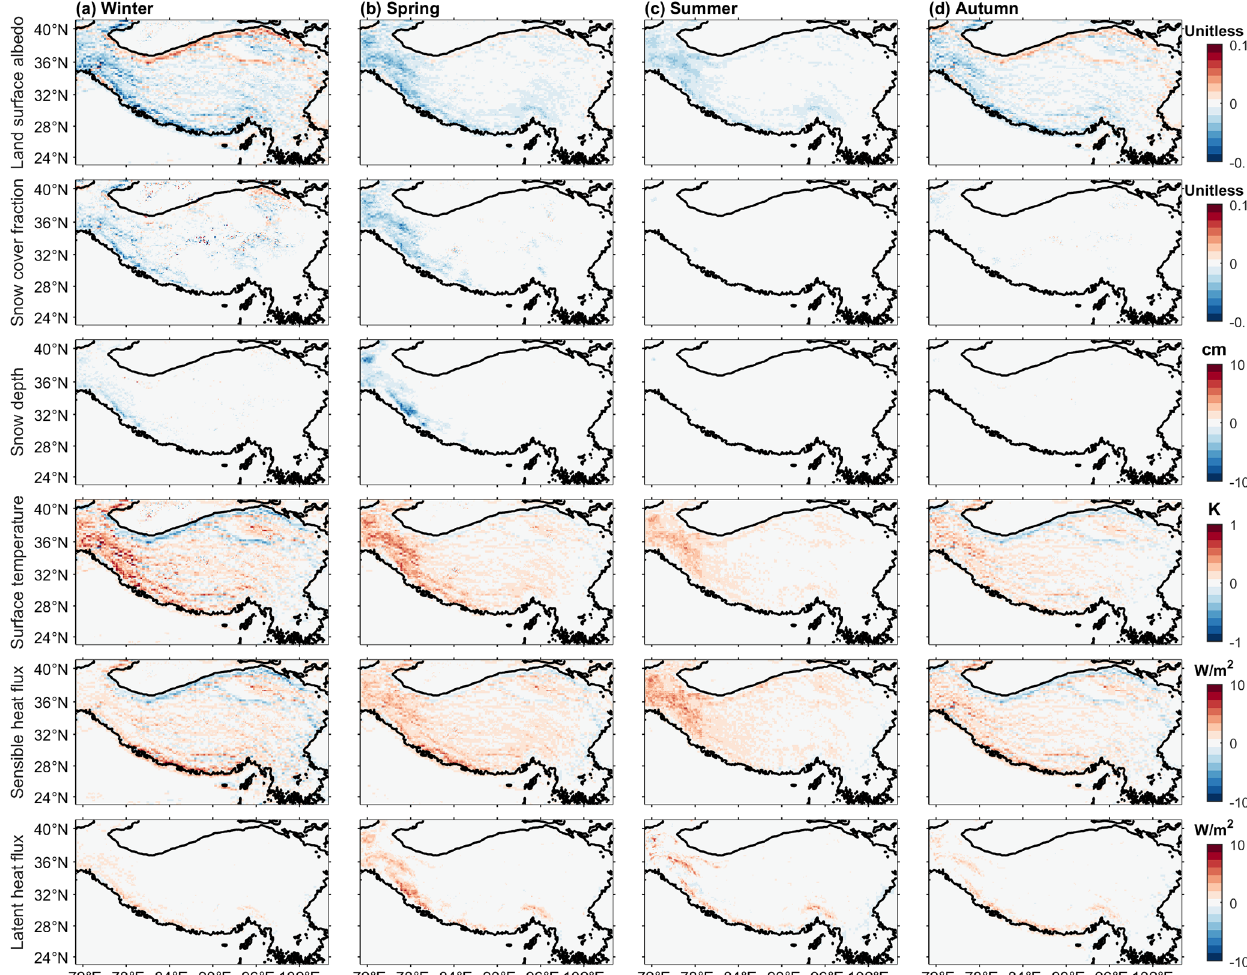
Figure 4. Absolute differences between TOP and PP for four seasons in different variables (from top to bottom): land surface albedo, snow cover fraction, snow depth, surface temperature, sensible heat flux, and latent heat